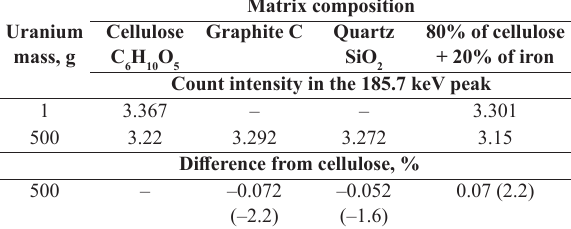
Table 3. Count intensities in the 185.7 keV peak with the back- ground deduction for different waste matrices and different urani - um masses in the cask (the waste material density is 0.708 g/cm 3 ) Matrix composition Uranium mass, g